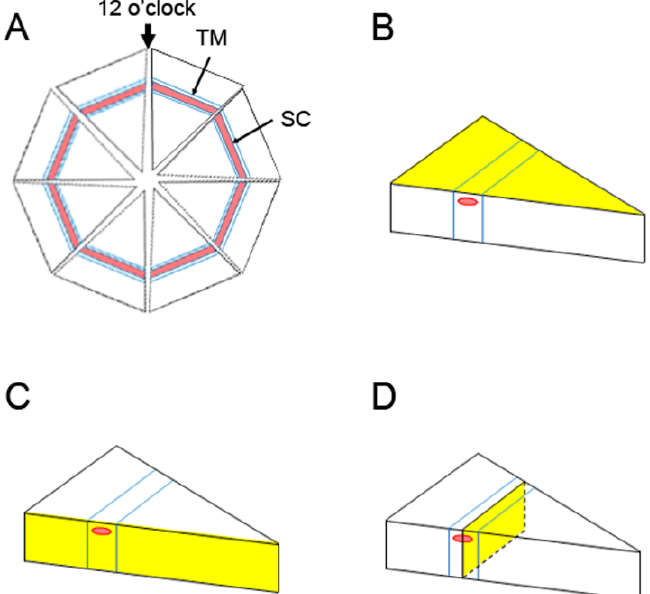
Figure 10. Dissection Methods and Imaging Planes. ( A ) Pattern of an enucleated eye dissected into eight radial wedges. Trabecular meshwork (TM) region and Schlemm’s canal (SC) are demarcated. Analysis of one of these eight wedges is illustrated in the following panels. The yellow surface represents the side of the tissue seen in the en face view ( B ), radial section ( C ), and frontal section ( D ). The frontal section plane usually bisects SC and the TM region, as shown here.